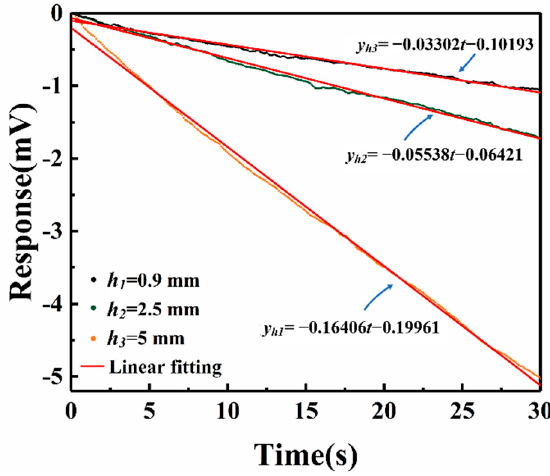
Figure 14. The response changed with different distances from the nozzle to the chip surface.